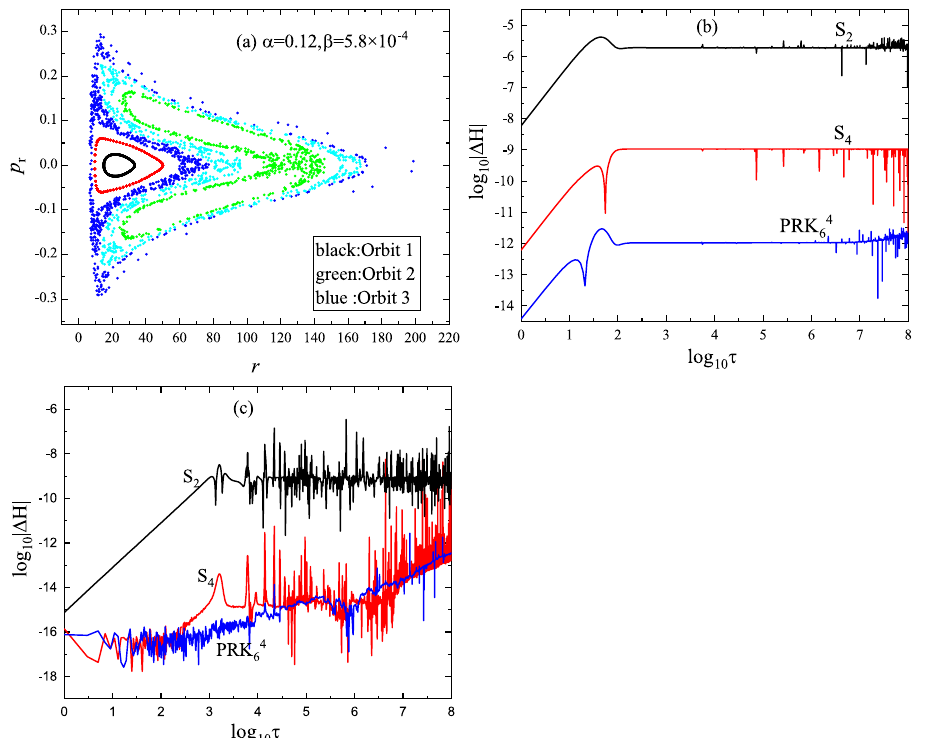
Figure 1. ( a ) Poincaré sections at the plane θ = π /2 with p θ > 0, where the phase space structures are described by the algorithm S 2 with the proper step h = 1. The parameters are E = 0.995, L = 4.6, α = 0.12 and β = 5.8 × 10 − 4 . The initial conditions are p r = 0 and θ = π /2. Orbit 1 with the initial separation r = 15 is a closed regular curve, and Orbit 2 with the initial separation r = 110 is chaotic. Orbit 3 with the initial separation r = 60 is also chaotic. ( b ) Hamiltonian errors ∆ H = H + 1/2 for the three symplectic methods acting on the ordered Orbit 1. The error for S 4 is about three orders of magnitude smaller than for S 2 , but larger than for PRK 6 4. ( c ) Hamiltonian errors ∆ H = H + 1/2 for the three symplectic methods acting on the chaotic Orbit 2. Although S 4 and PRK 6 4 have higher accuracies than S 2 in an integration time, they would approach S 2 in secular error behavior due to roundoff